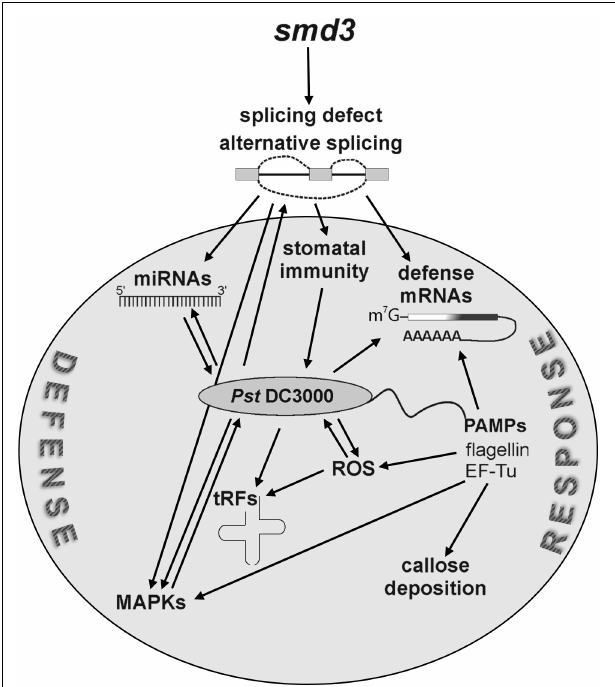
FIGURE 7 | SmD3 affects several aspects of plant immunity through regulation of splicing of key pathogenesis factor mRNAs. Splicing defects in smd3 mutants impact stomatal immunity, induction of pathogen-related proteins, including WRKY transcription factors, MAPKs cascade signaling, ROS production and miRNA-dependent fine-tuning of plant